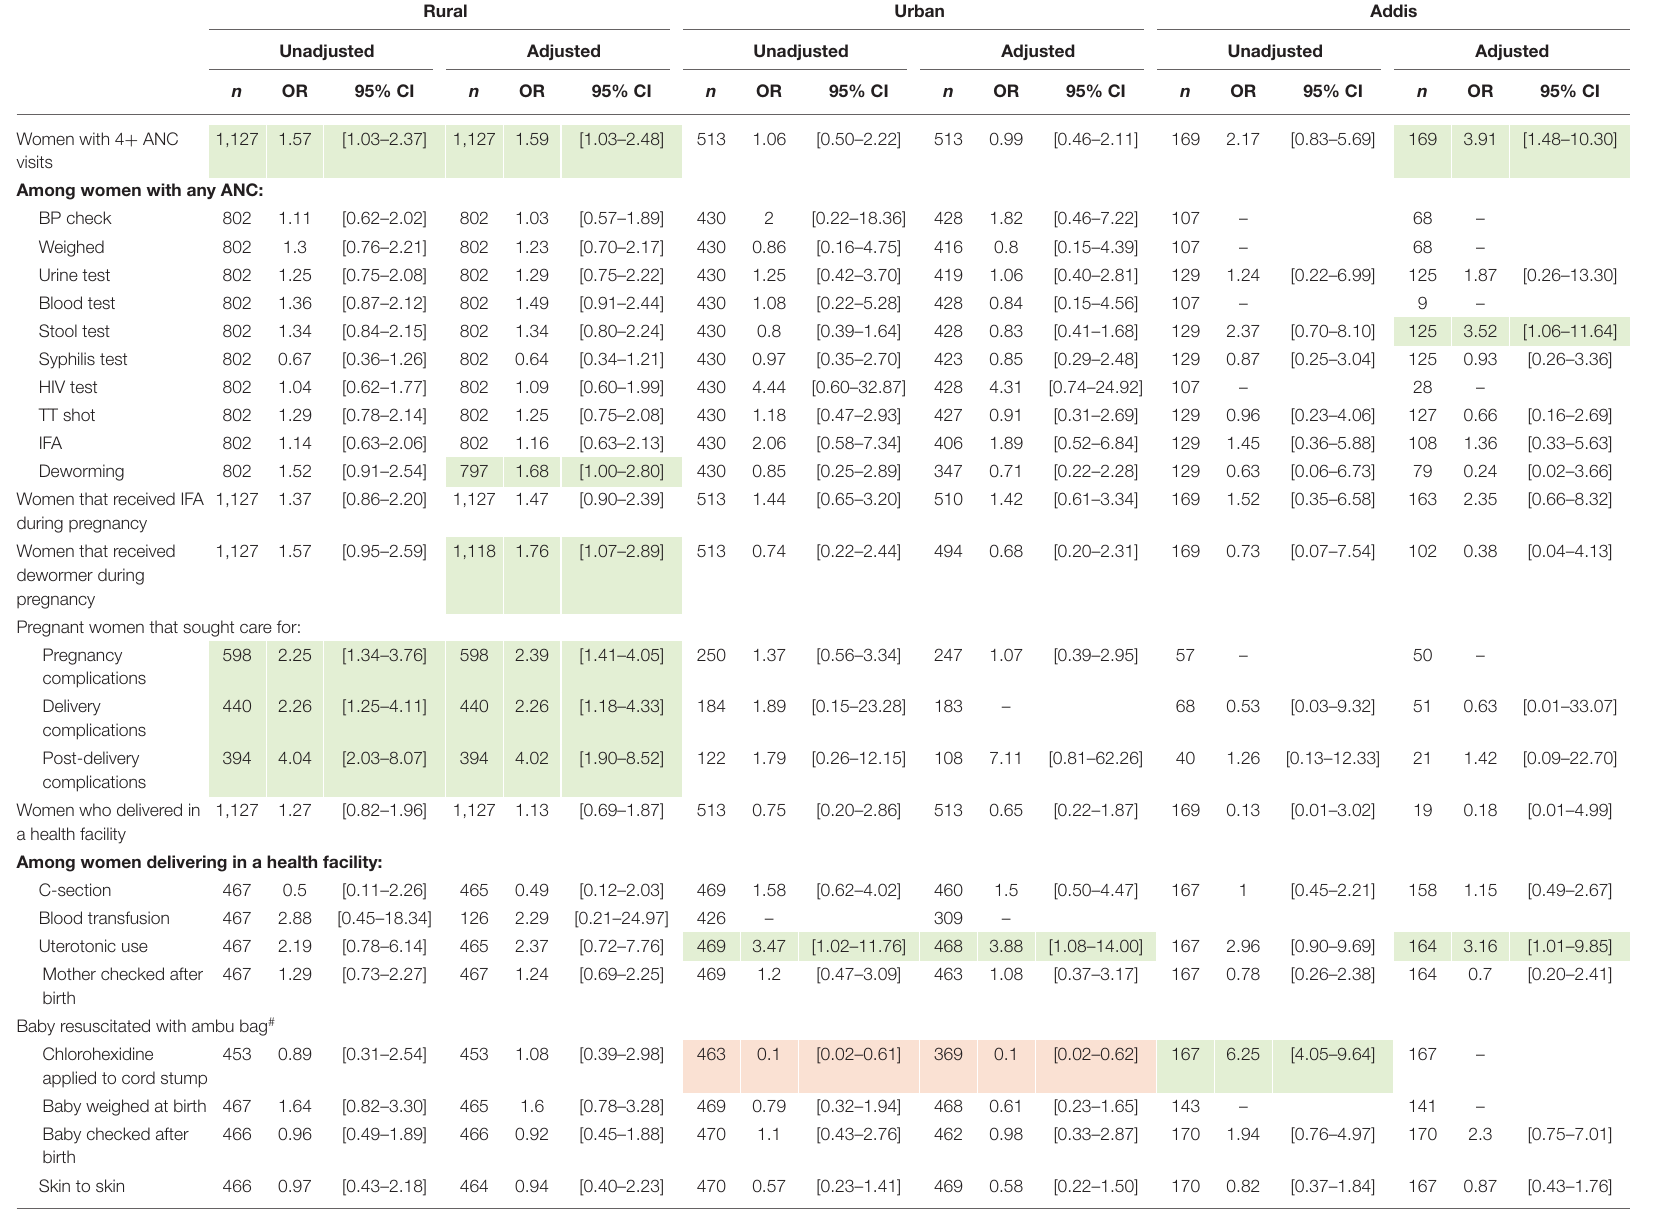
TABLE 3 | Odds of intervention receipt in COVID-19 impacted cohort vs. unaffected reference cohort by urban (Addis and other urban areas) and rural areas. Rural Urban Addis Unadjusted Unadjusted